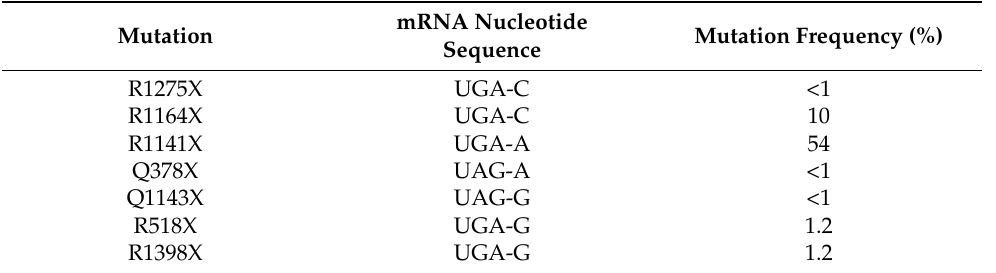
Table 1. Pseudoxanthoma elasticum nonsense mutations given in order of decreasing full-length protein expression level induced by incubation with 5 µ g/mL